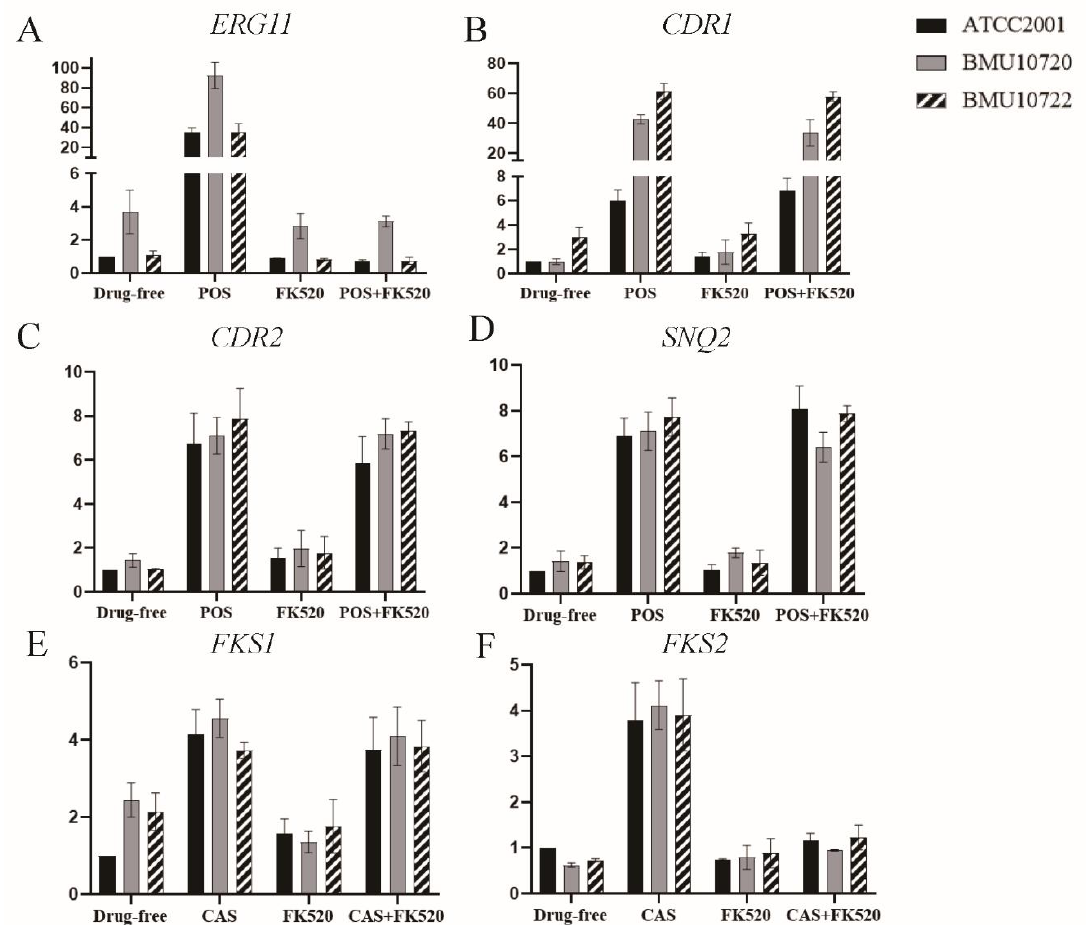
Figure 2. The expression level of resistance-related genes in ATCC2001, BMU10720, and BMU10722. For each target gene, the relative amount of expression was compared to that of RDN5.8 as an internal control. The treatment of each group in detail was in the text. Data presented as means ± SE (error bars) from biological triplicates with technical triplicates.